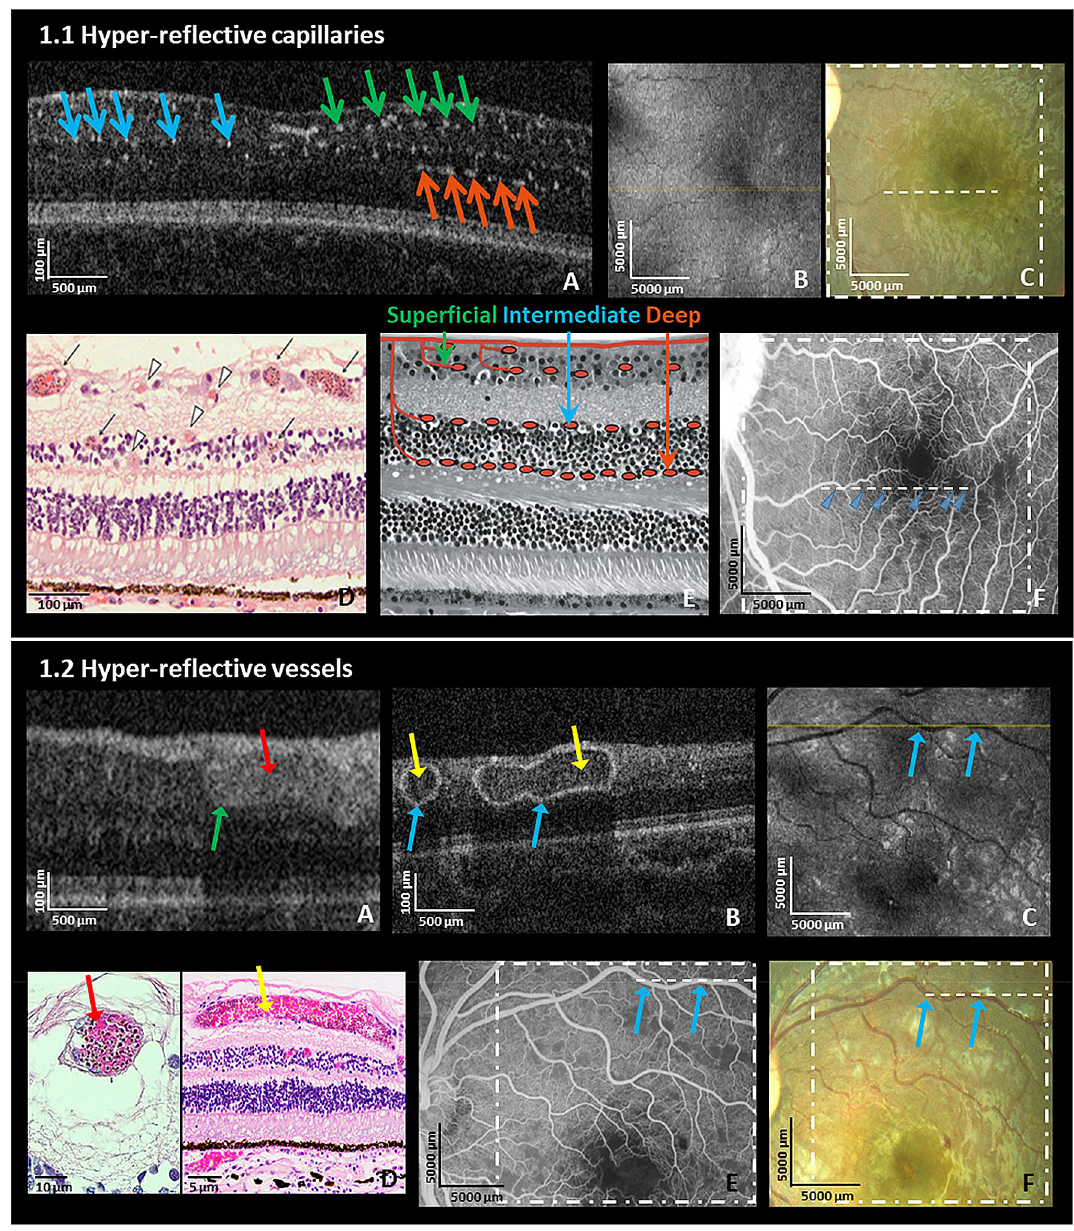
Figure 1. Hyper-reflective capillaries and vessels. ( 1.1 ) Left eye of a 7-month old male CM patient on admission. ( A ) HH-OCT B-scan showing hyper-reflective dots corresponding to locations of capillaries (green, blue and orange arrows: superficial, intermediate and deep capillary plexus); ( B ) En-face OCT displays no visible change; (yellow line: location of the OCT B-scan in the image ( A )). ( C ) Fundus photo; dashed line and square correspond to ( A, B ); ( D ) Representative retinal cross-section histology from a different fatal patient showing capillaries and venules affected by parasite sequestration (black arrows: intense sequestration; arrowheads: low or no sequestration); Reprinted with permission 25 ; ( E ) Schematic representation of superficial, intermediate and deep capillary plexus collocated to capillaries filled with pRBCs on OCT in ( A ). Reprinted with permission 24 ; ( F ) Fundus fluorescein angiography (FA) shows perfusion deficits of capillaries (blue arrows) corresponding to parasitized vessels on OCT in the same location of ( 1.1.A ). ( 1.2 ) Left eye of a 42-month old male CM patient on admission. ( A ) Hyper-reflective vessel (blue arrow) corresponding to localization of vessel on fundus photo and FA (not shown) with hyper-reflective lumen (red arrow); and ( B ) Hyper-reflective vessels (blue arrows) with hypo-reflective lumina (yellow arrows) on OCT B-scans; ( C ) En-face OCT (yellow line: location of OCT B-scan in B, blue arrows: vessels shown in ( B ); ( D ) Representative retinal cross-section histology showing pRBCs in venules from a different fatal patient (red arrow shows vessels with pRBCs filling the lumen; yellow arrow shows a vessel where pRBCs cytoadhere to the vessel wall with red blood cells without parasites in the center of the vessel (similar to hypo-reflective lumina of blood vessels in ( 1.2.B ); ( E ) Fundus fluorescein angiography and ( F ) Fundus photo corresponding to OCT in ( 1.2.B ) (blue arrows corresponding to vessels in the image ( B ); dashed line and square correspond to ( B, C